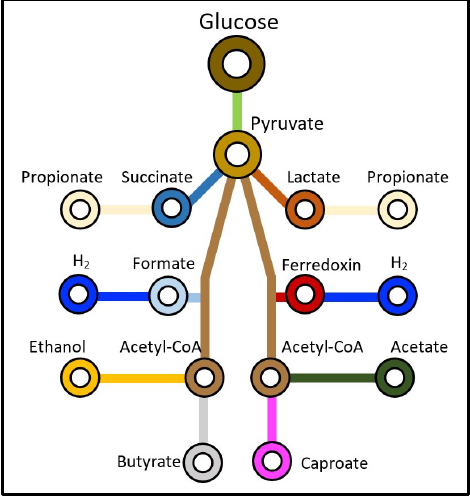
Figure 1. Conversion routes for glucose in dark fermentation processes, adapted from [14].